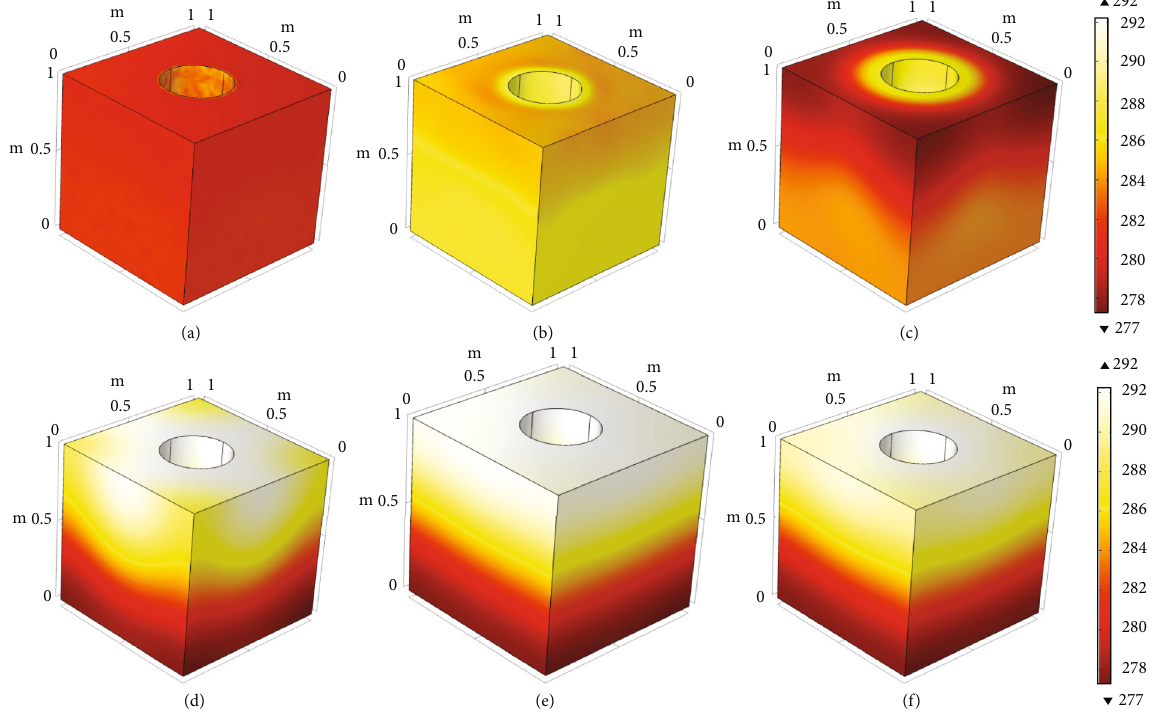
Figure 13: Thermal fi eld in the m = 7 coal rock: (a) t = 0 : 1 s , (b) t = 1 × 10 3 s, (c) t = 1 × 10 4 s, (d) t = 1 × 10 5 s, (e) t = 1 × 10 6 s, and (f) t = 1 × 10 7 s.